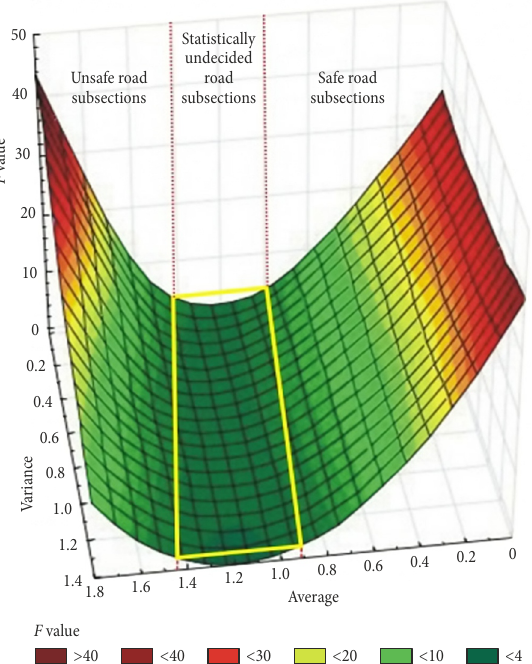
Fig. 6. Common three-dimensional display of ε , v and F values for all observed subsections